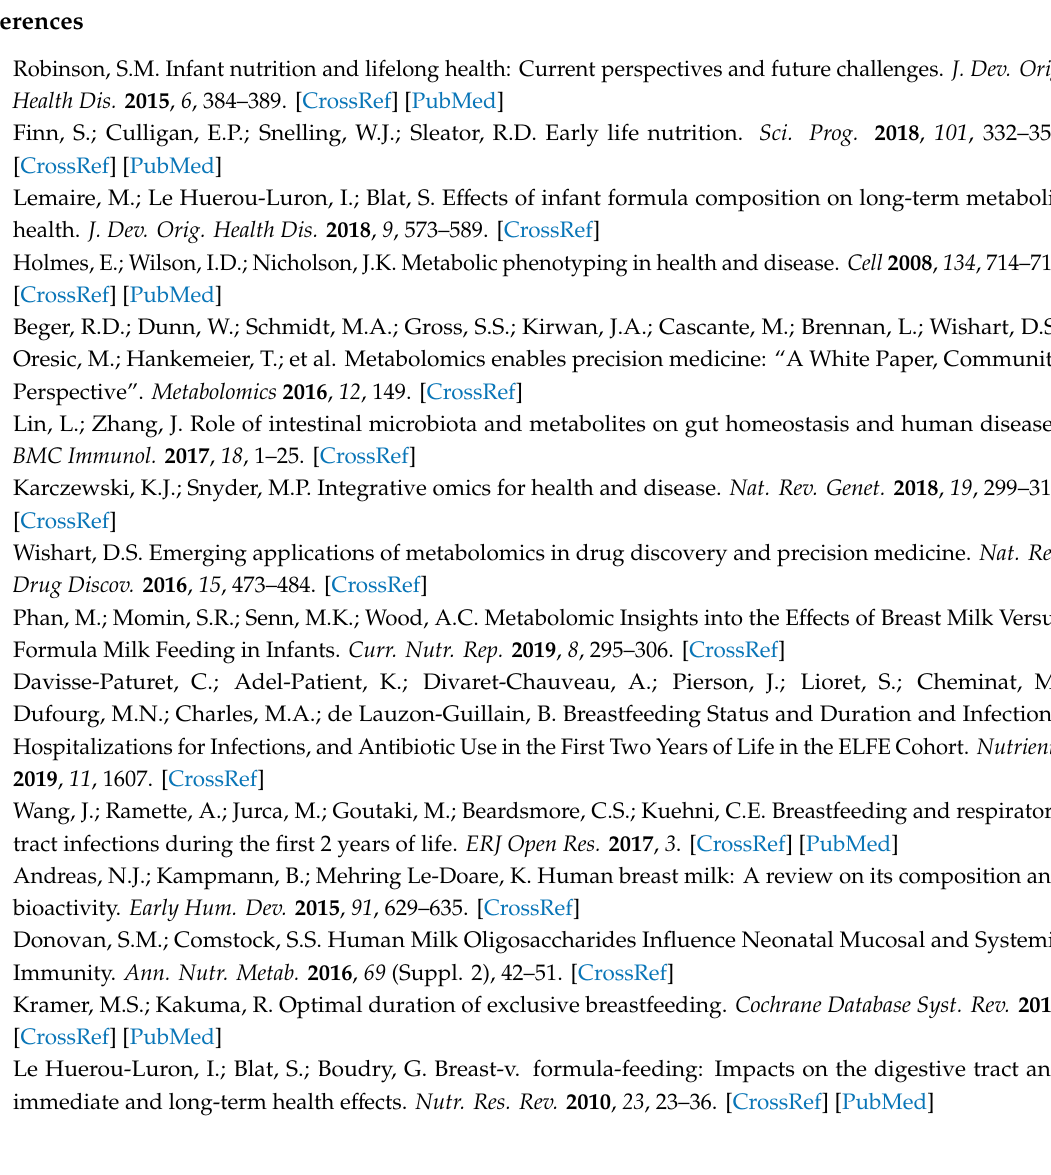
biofluids. Table S3: Scoping review of metabolites in healthy infants < 12 months old by diet; example